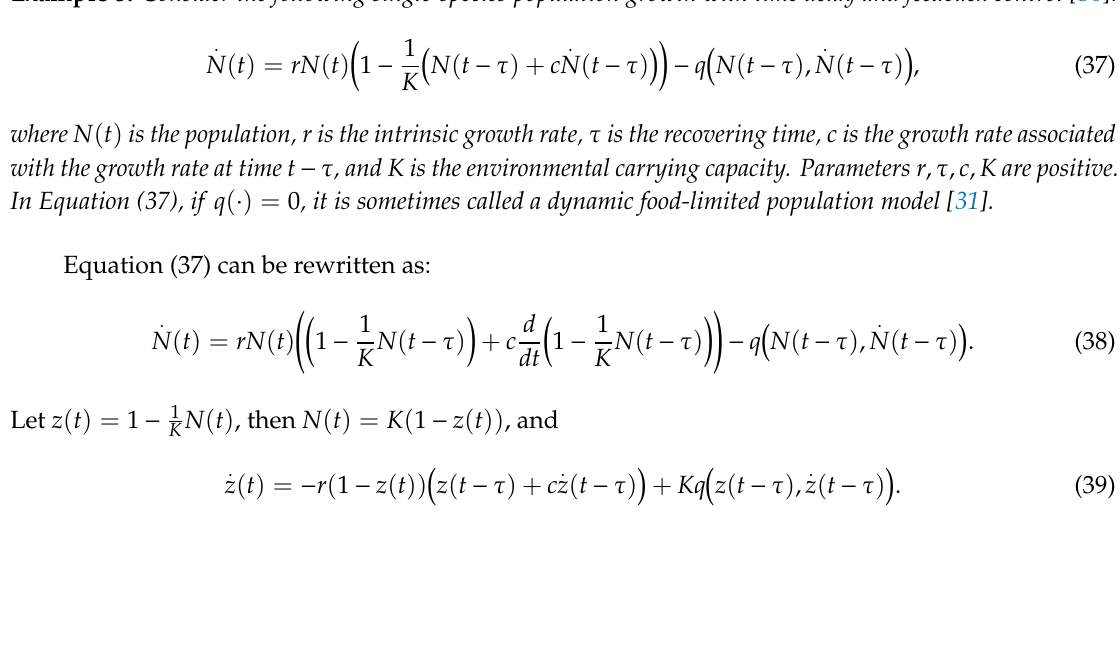
Figure 3. System response ( a ) without state feedback, and ( b ) with a state feedback controller for k p = 1.23336 and k d = − 2.5. The chosen state feedback controller gain exponentially stabilizes the NDDS.